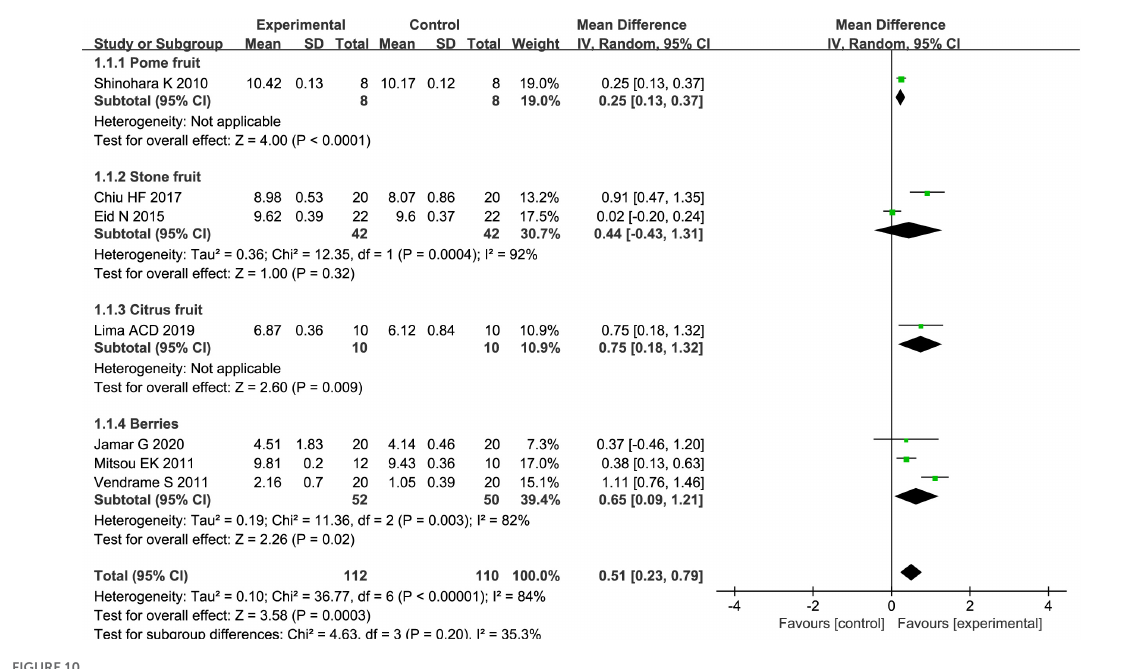
FIGURE10 Intervention effect of different types of fruits vs. placebo for Bifidobacterium on patients in subgroup meta-analysis.